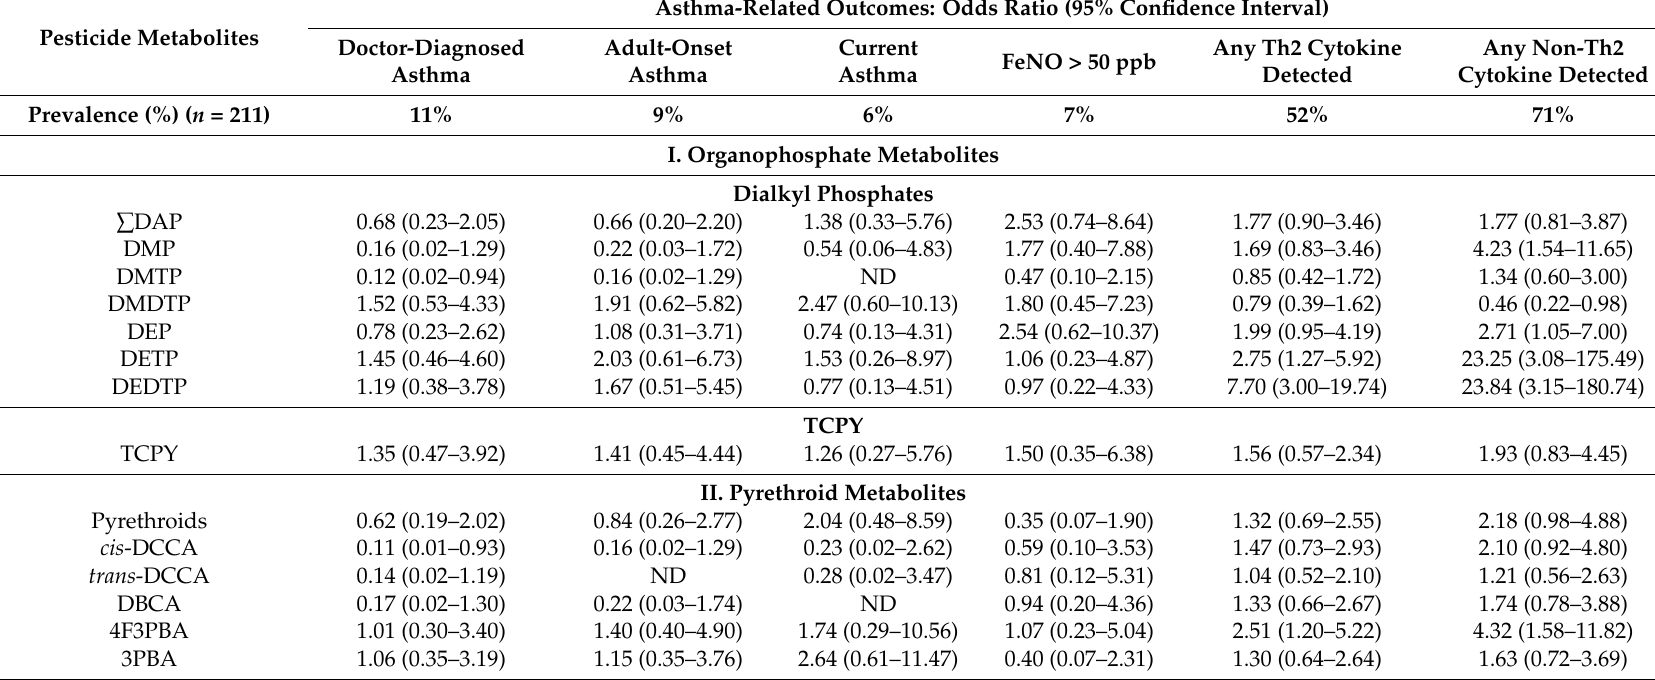
Table 5. Adjusted multiple logistic regression models of the association between pesticide metabolites and asthma-related outcomes among rural women. Asthma-Related Outcomes: Odds Ratio (95% Confidence Interval) Pesticide Metabolites Doctor-Diagnosed Adult-Onset Current Any Th2 Cytokine Any Non-Th2 FeNO > 50 ppb Asthma Asthma Asthma Detected Cytokine Detected Prevalence (%) ( n = 211)